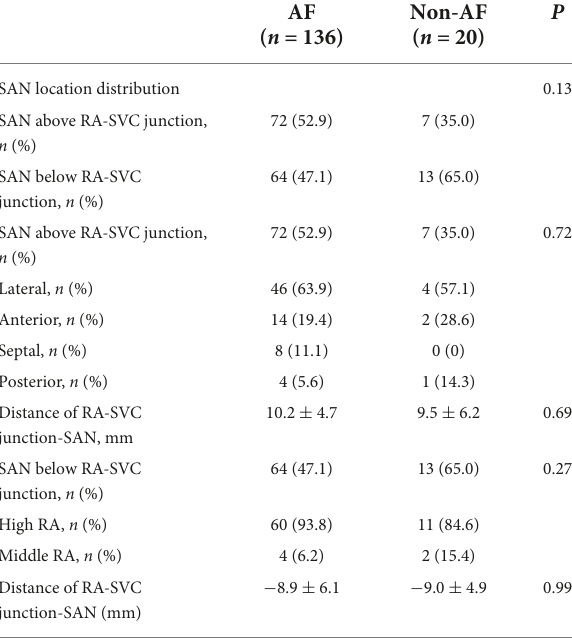
the SVC in patients with AF, and the mean distance determined by the electrical measurement was 33 ± 7 mm, ranging from 24 to 44 mm (20). More recently, ultra-high-resolution human SVC mapping conducted by Miyazaki et al. demonstrate that SVC musculature sleeve length was asymmetric and longest at the anteroseptal SVC (27.0–28.0 mm) and was shortest at the